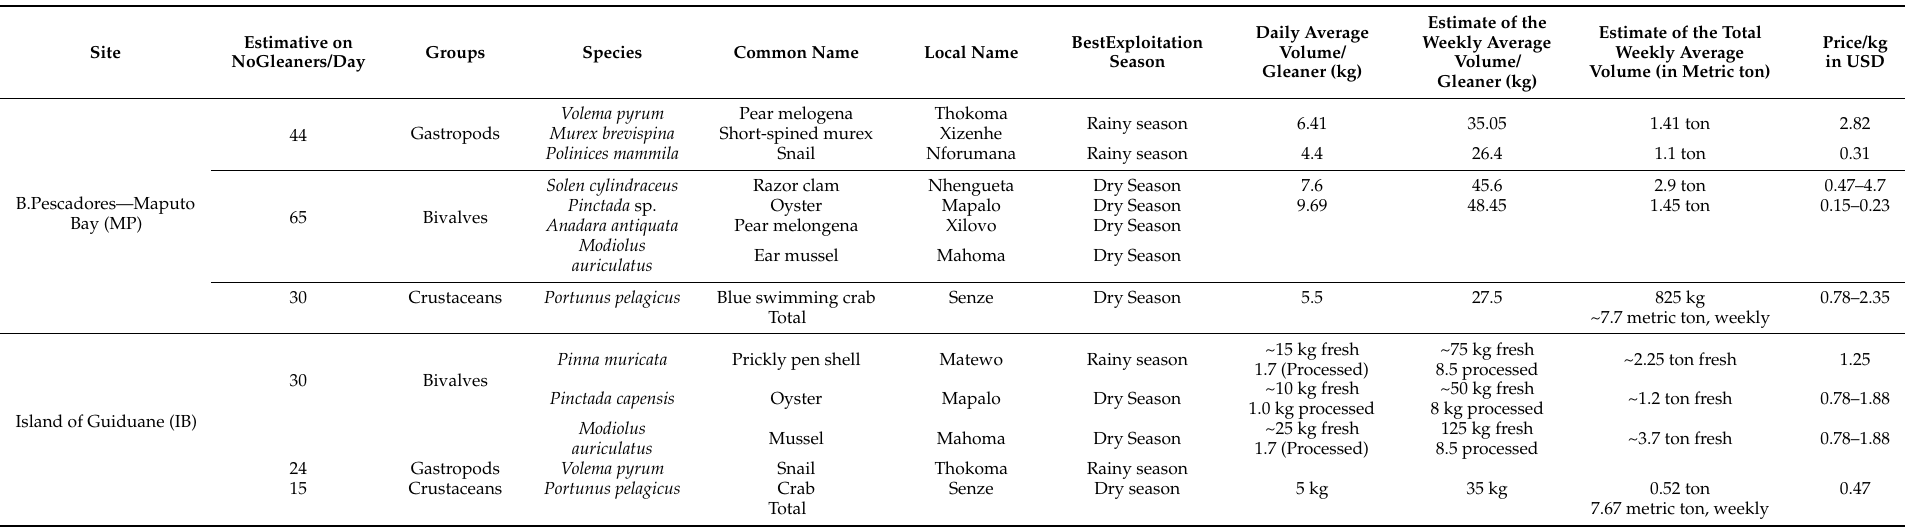
Table 5. Most commercially important resources and exploration details in Bairro dos Pescadores western Maputo Bay (MB) and Guiduane Island